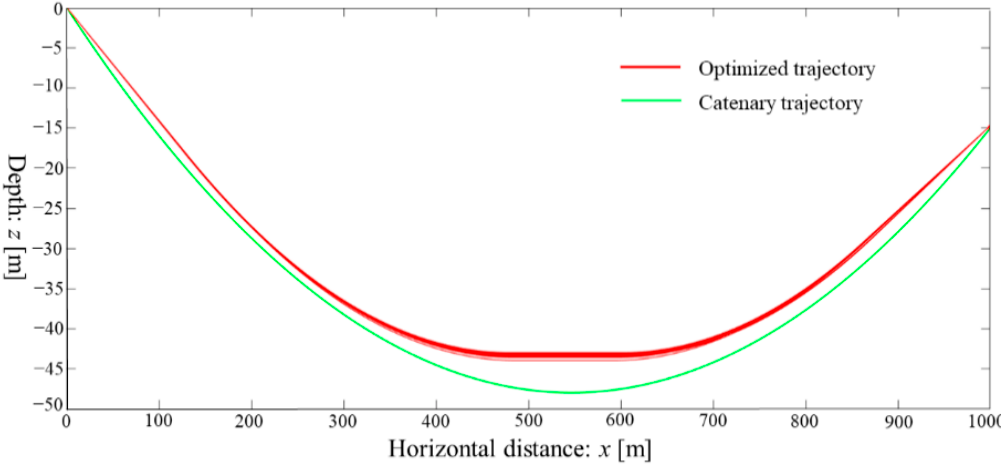
Figure 13. The shortest total length trajectories after searching 20 times by IRMO.